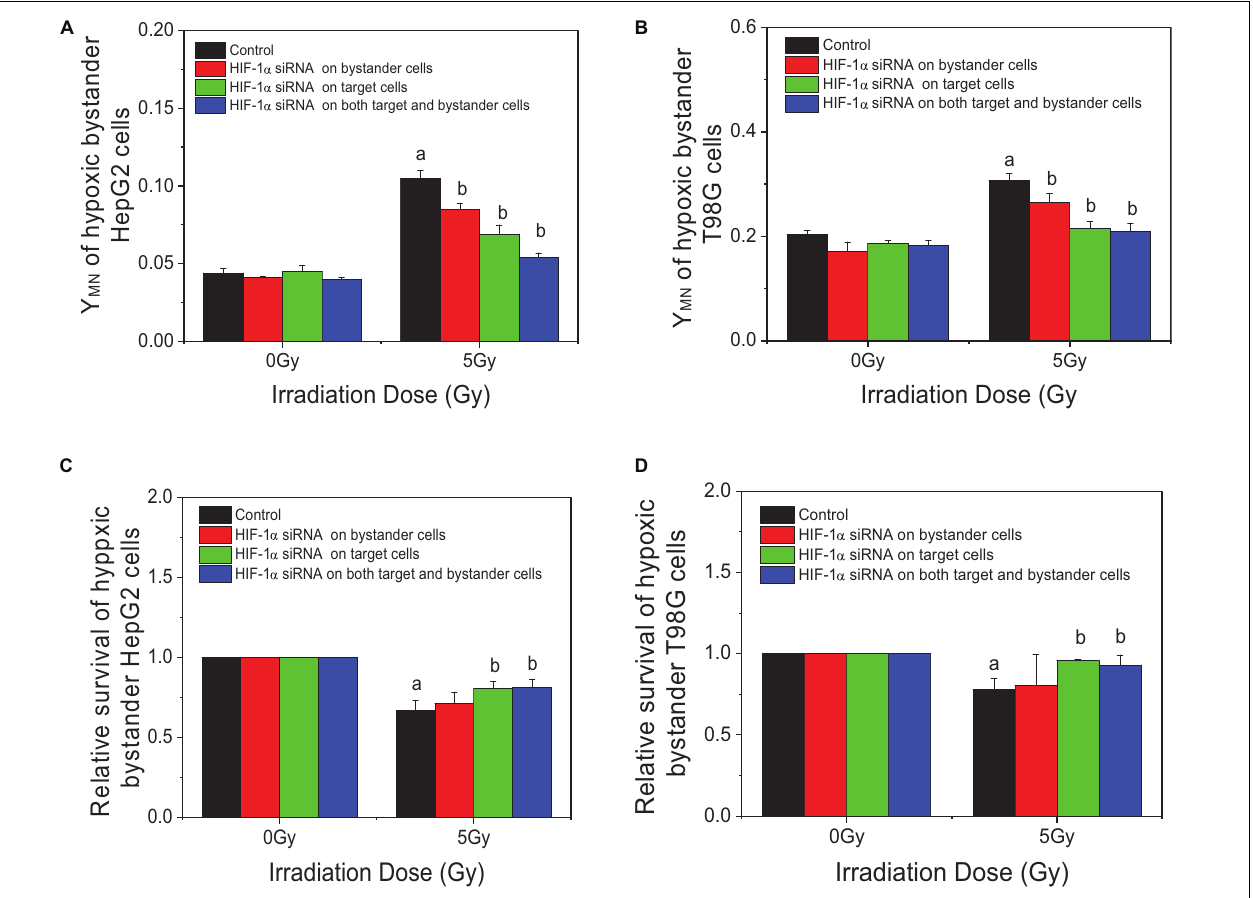
FIGURE 5 | Inhibition responses of HIF-1 α expression on the target (irradiated) and/or bystander HepG2 cells and T98G cells under hypoxic conditions. Four groups in this experiment: Control group, bystander cells only were treated with the conditioned-medium from irradiated conspecific cells; Inhibition of bystander cells, only bystander cells were pretreated with HIF-1 α siRNA, then incubated with the conditioned medium from irradiated conspecific cells. Inhibition of target cells, only target cells pretreated with HIF-1 α siRNA, then harvested and the conditioned medium transferred to bystander cells. Inhibition on both target and bystander cells, target and bystander cells were pretreated with HIF-1 α siRNA, then the conditioned medium added to bystander cells. (A,C) Micronucleus induction in the bystander cells. (B,D) Survival fractions of bystander cells. a, p < 0.05 compared with the 0-Gy group; b, p < 0.05 compared with the 5-Gy group without